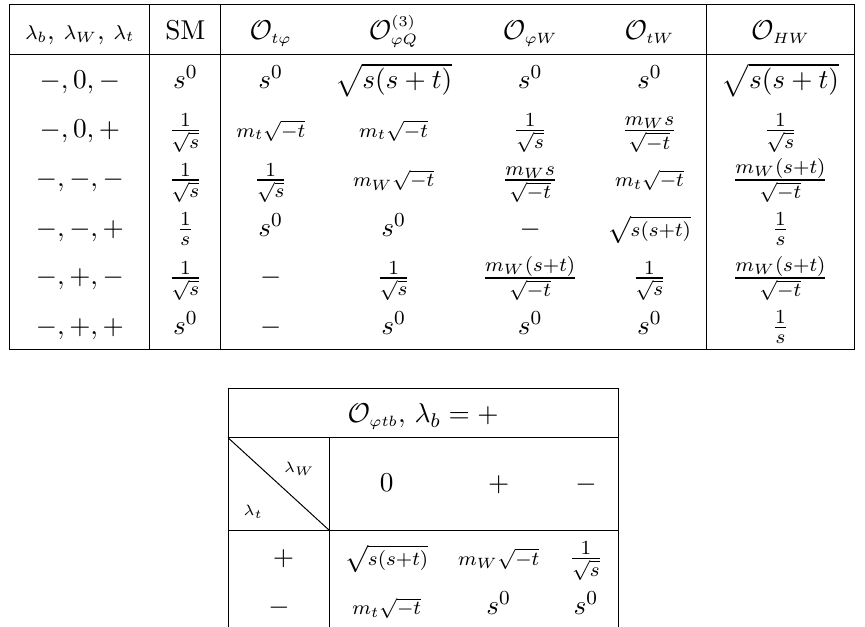
Table 2 . Energy growth of the helicity amplitudes in the b W energy limit, s; t v with s=t constant. The energy dependence of amplitudes that do not grow (cid:0) (cid:29) with energy is schematically denoted by corresponding powers of s . The RHCC operator ( contributions are collected separately due to the fact that it is the only operator that can yield right handed b -quark con(cid:12)gurations in the 5-(cid:13)avour